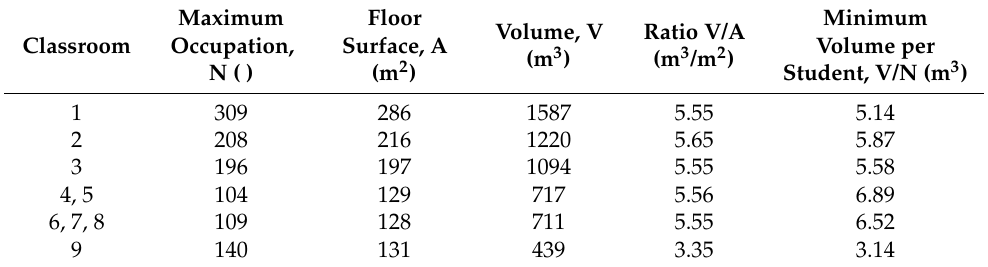
Table 3. The geometric characteristics of the nine classrooms in the selected